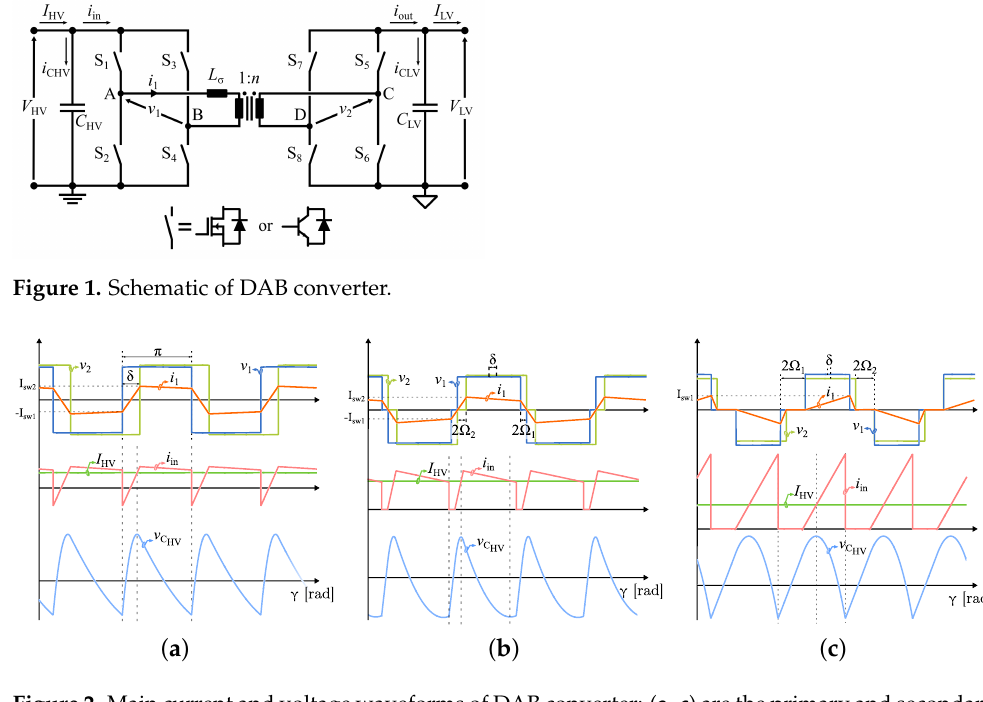
) in these modulation methods. CHV